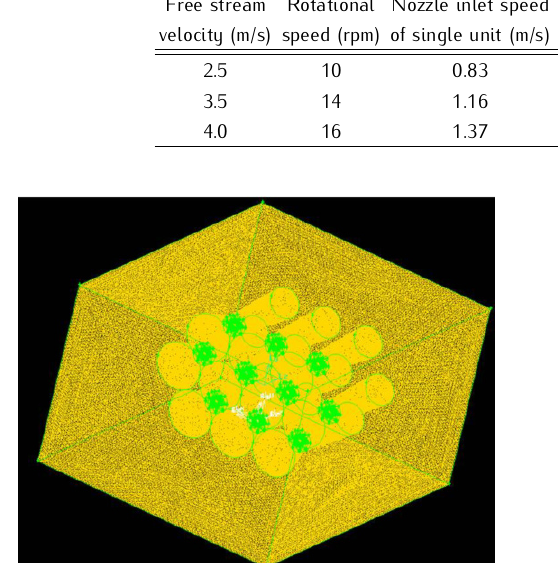
Figure 9. Mesh densities in the regions: green regions showing the CMMCT units of the array.